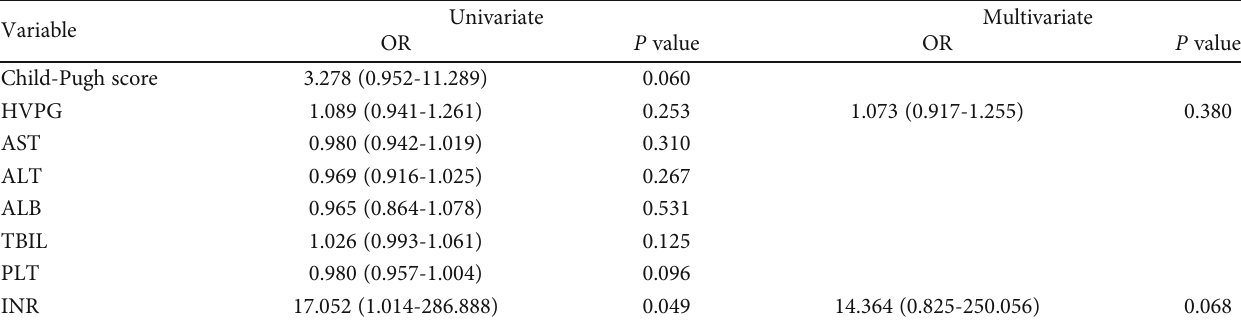
Table 3: Univariate and multivariate logistic regression analysis in the ascites cohort.